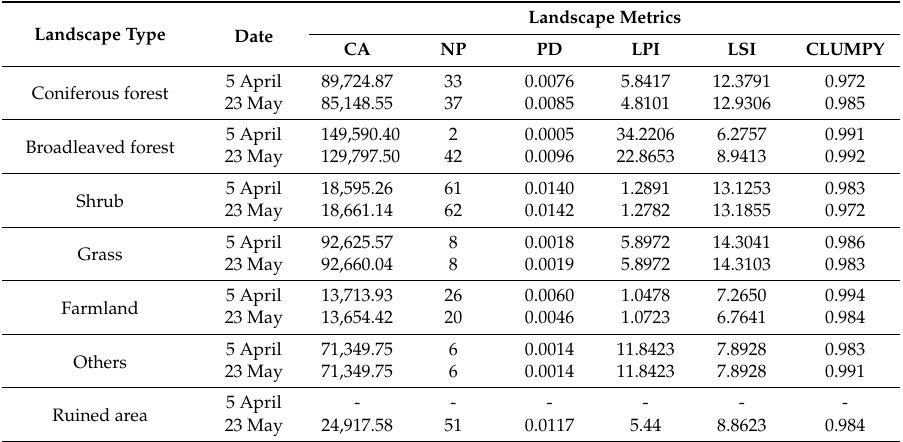
Table 1. Characteristics of spatial heterogeneity of vegetation at class level before and after the earthquake. CA, Class Area; NP, Number of Patches; PD, patch density; LPI, Largest Patch Index; LSI, Landscape Shape Index; CLUMPY, Clumpiness Index.